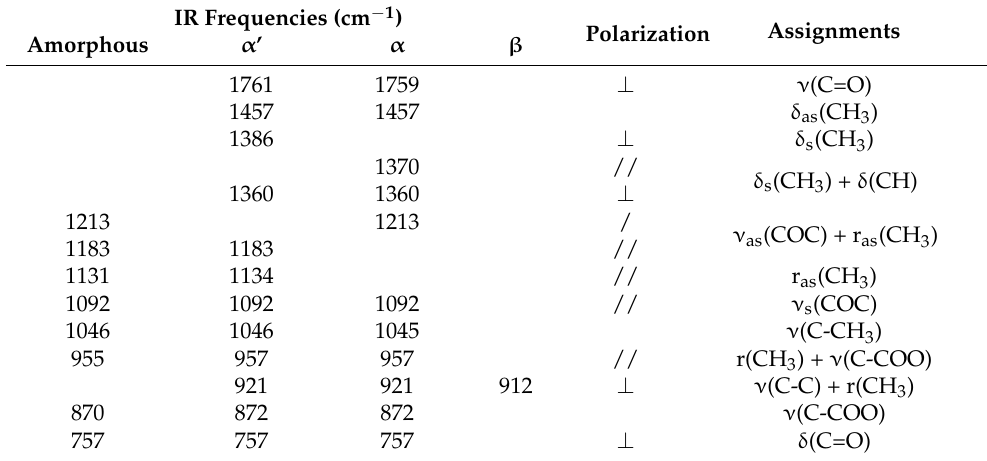
Table 1. Characteristic infrared band assignments of PLLA in the range of 1800-600 cm − 1 . IR Frequencies (cm − 1